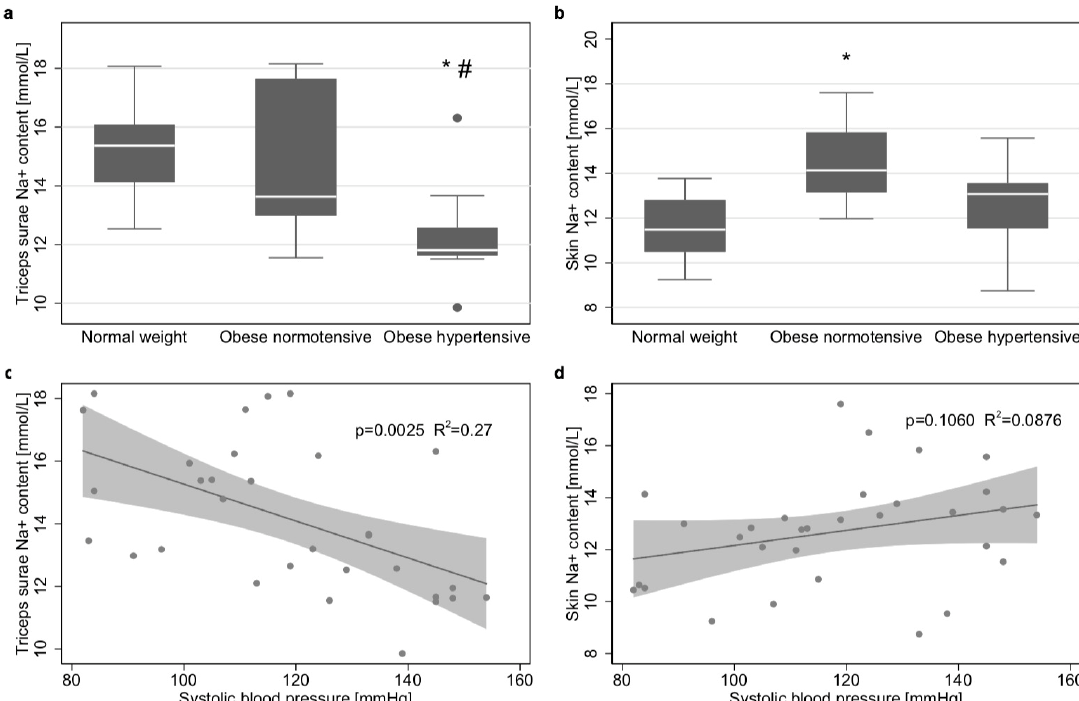
Figure 2. Na + content in di ff erent tissues. ( a ) Boxplots of triceps surae muscle Na + of controls, normotensive obese and hypertensive obese. ( b ) Boxplots of skin Na + content of controls, normotensive obese and hypertensive obese. Tests were performed using a Kruskal–Wallis Test (N = 32) with inter-group p -values according to Bonferroni corrected Dunn’s test. * p -value < 0.05 compared to controls # p -value < 0.05 compared to normotensive obese. 1 diastolic hypertension (above the 95th percentile). ( c ) The scatter plot and the linear regression model show an inverse correlation between triceps surae Na + content and systolic blood pressure ( p = 0.0025, R 2 = 0.27, N = 32). ( d ) Scatter plot and the linear regression model, showing no significant correlation between skin Na + content and systolic blood pressure (p = 0.1060 R 2 = 0.09).